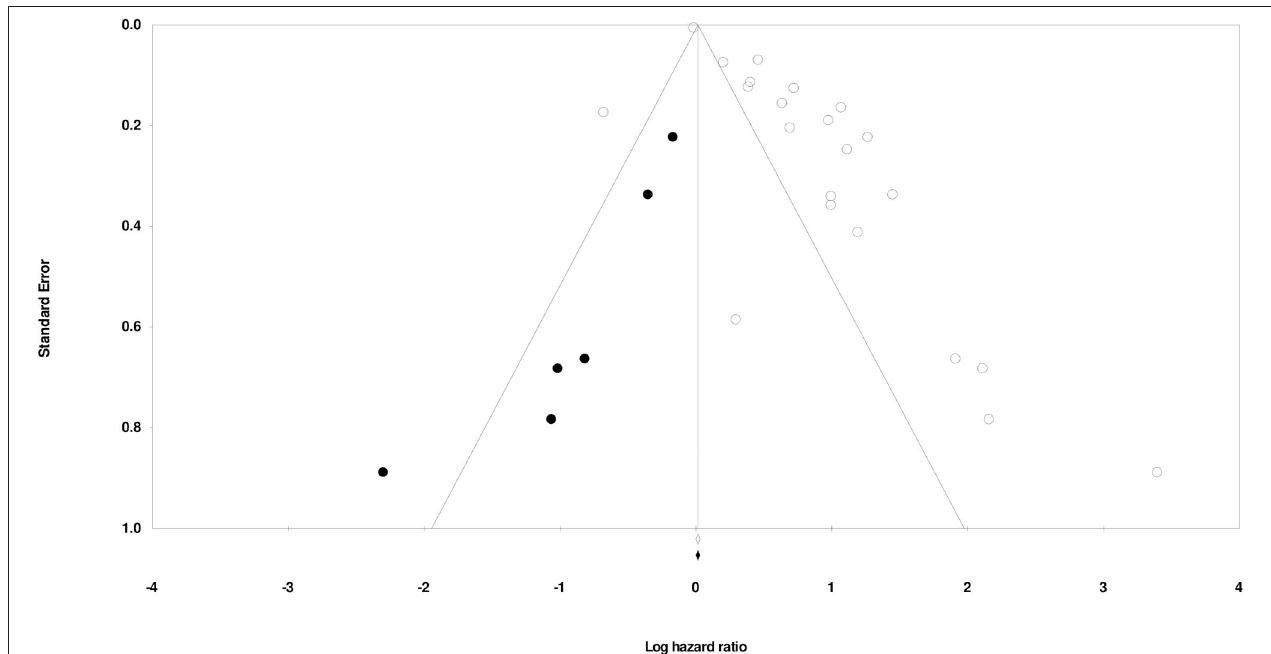
FIGURE 3 | Publication bias as determined using Duval & Tweedy’s trim and fill